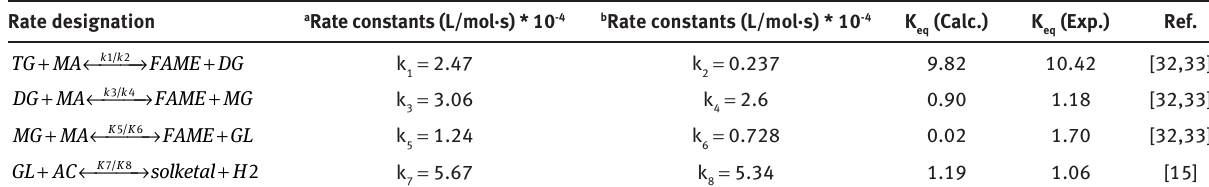
Table 3: Theoretical and experimental values of equilibrium rate constants at 50°C, 10:1 of methanol to oil molar ratio, and 4:1 of acetone to oil molar ratio.